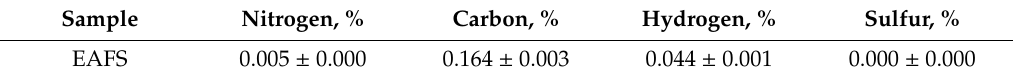
Table 7. Elemental analysis of the electric arc furnace